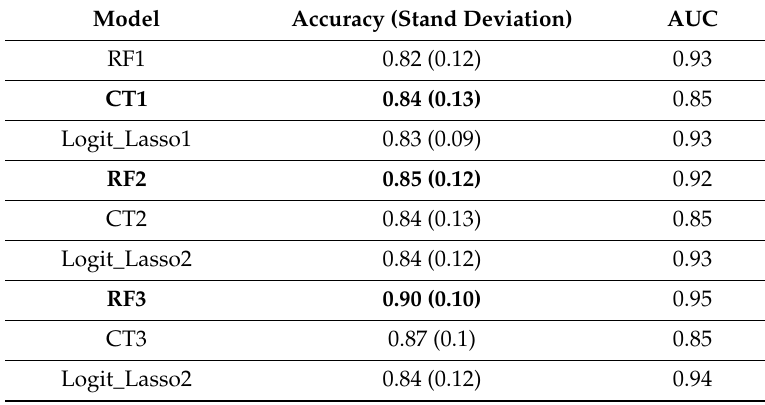
Table 3. Model performance comparison. The average accuracy rate and Area Under the Curve (AUC) score calculated on the test sets from 250 replications. Model number indicates the input features used in the model. (RF = Random Forest; CT = Classification Tree; Logit_Lasso = Logistic Lasso classification). The number in the parenthesis is the stand deviation of accuracy. The accuracy in bold indicates the best performance in each of three types of models (RF, CT, and